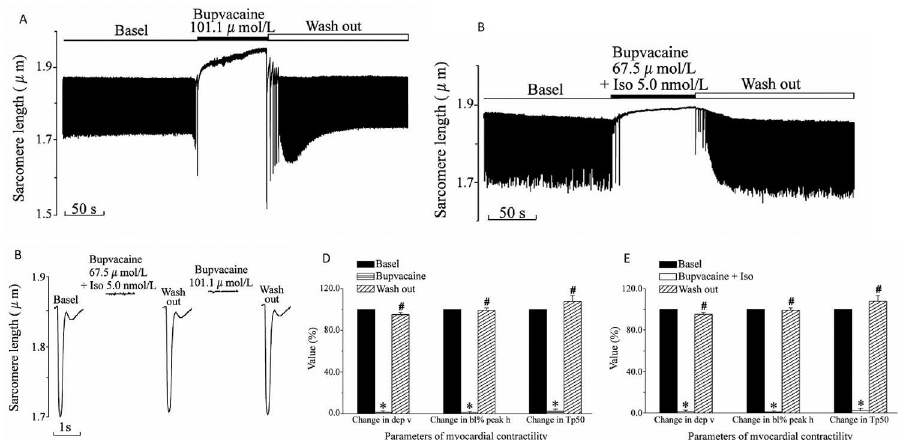
Fig 6. Removal of bupivacaine and isoprenalin restored cell contractility. (A) and (B) Representative sarcomere shortening perfused with bupivacaine in the presence or absence of isoprenalin, and after washing with Tyrode’s solution. (C) Individual signals of sarcomere shortening (obtained by averaging of ten successive recordings) in the presence of bupivacaine, with or without isoprenalin. (D) and (E) Statistical analysis of effect of bupivacaine on bl% peak h, Tp50 and dep v. Data are the mean ± SD. (cid:3) P < 0.05, vs . basal amplitude; P < 0.05, vs . removal of bupivacaine and